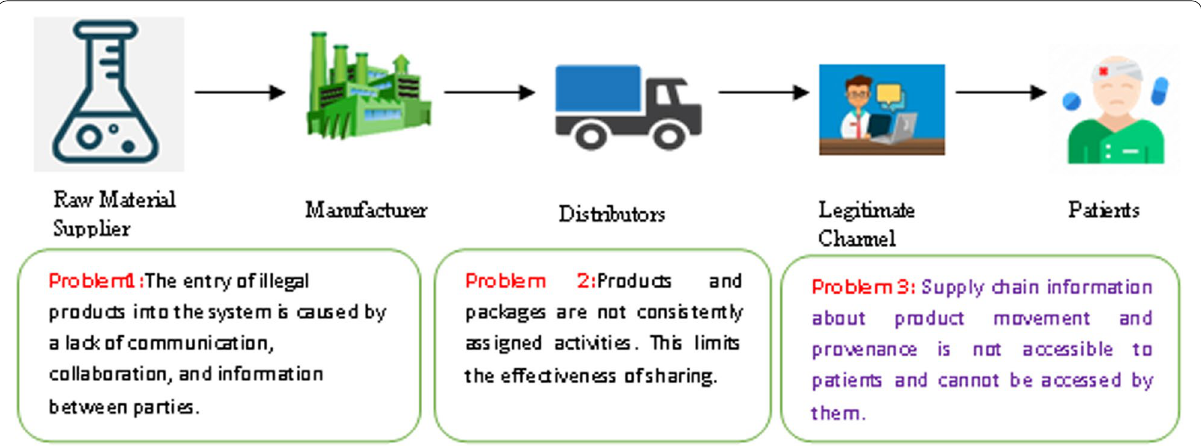
Fig. 1 A Challenge of